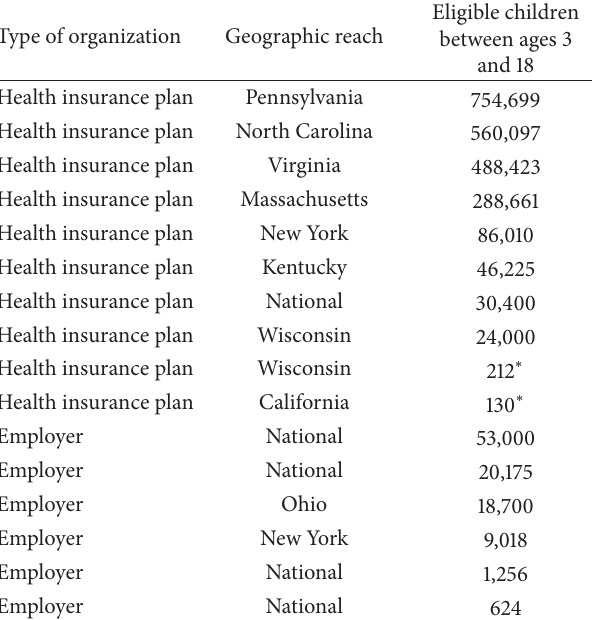
Table 2: Summary of participating